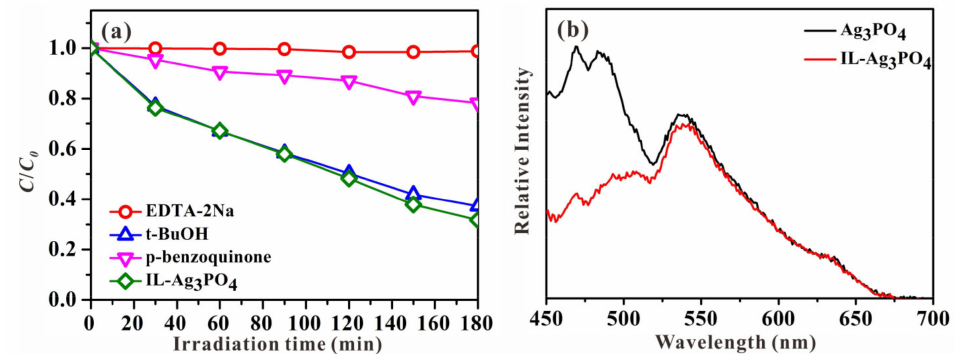
Figure 6. ( a ) Photocatalytic activities of the IL-Ag 3 PO 4 for the degradation of RhB in the presence of different scavengers; ( b ) photoluminescence (PL) spectra of Ag 3 PO 4 and IL-Ag 3 PO 4 .